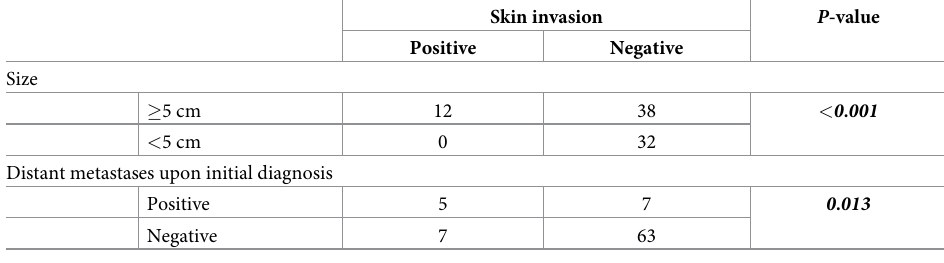
Table 4. Associations with tumor-skin invasion in superficial soft tissue